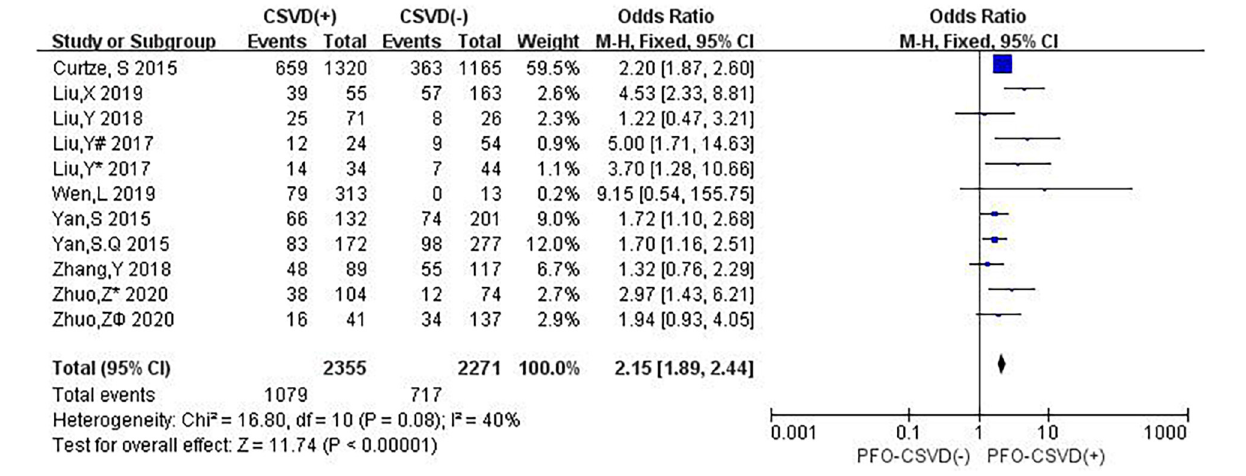
FIGURE 8 | Forest plot showing the impact of CSVD on 3-month PFO. (Liu, Y # 2017 and Liu, Y* 2017 are from Liu, Y 2017 (Liu et al., 2017); Liu, Y # 2017 represents the data of WMH in this study, and Liu, Y* 2017 represents the data of LI in this study; both Zhuo Z* 2020 and Zhuo Z φ 2020 are from Zhuo et al. (2020); Zhuo Z* 2020 represents the data of LI in this study, and Zhuo Z φ 2020 represents the data of CMB in this study).